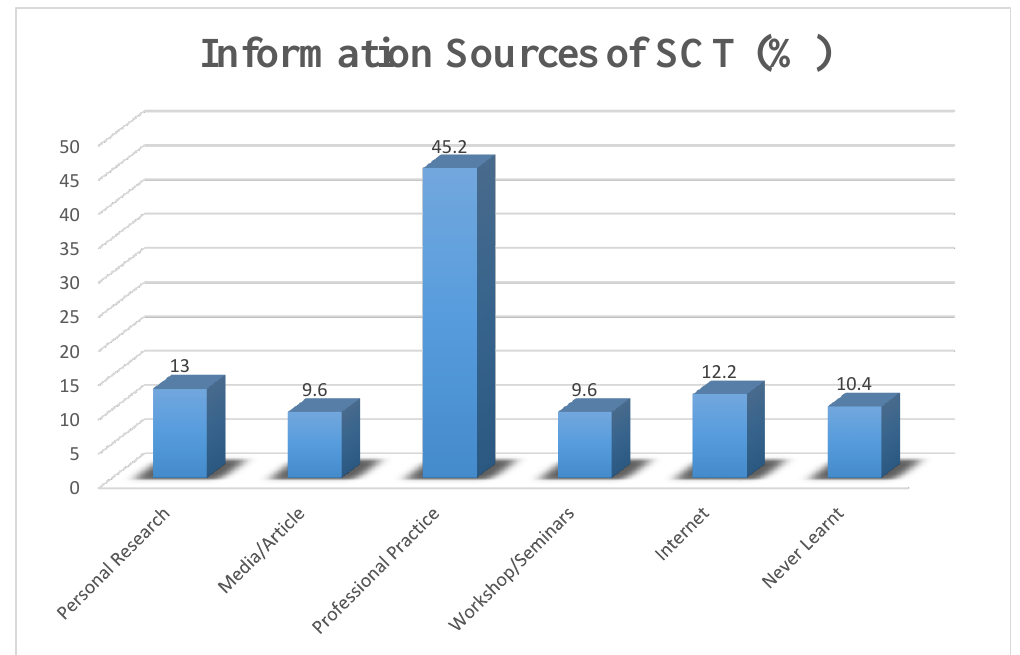
Figure 1. Information sources of the self-curing technique.